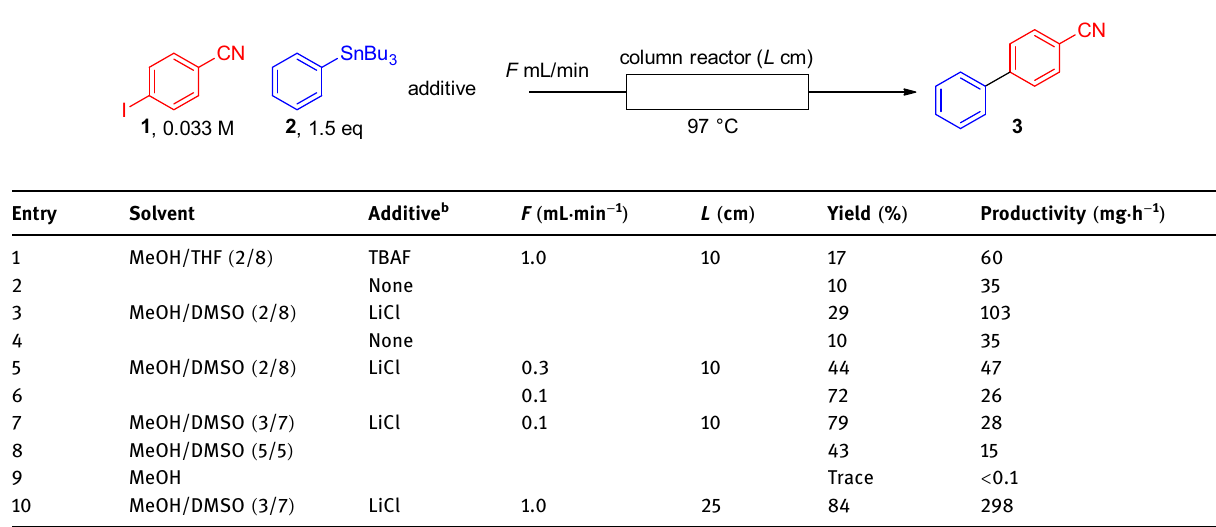
Table 2: Investigation for fl ow Stille coupling a